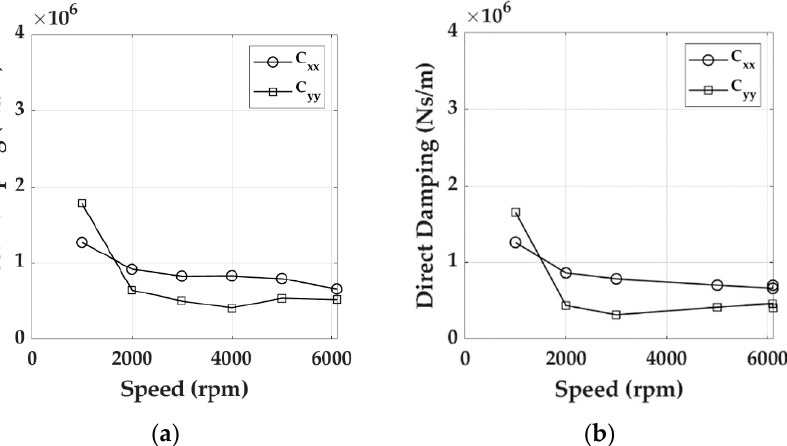
Figure 35. Flooded Rocker Pivot bearing synchronous direct damping: ( a ) 1.3 MPa, ( b ) 2.1 MPa.